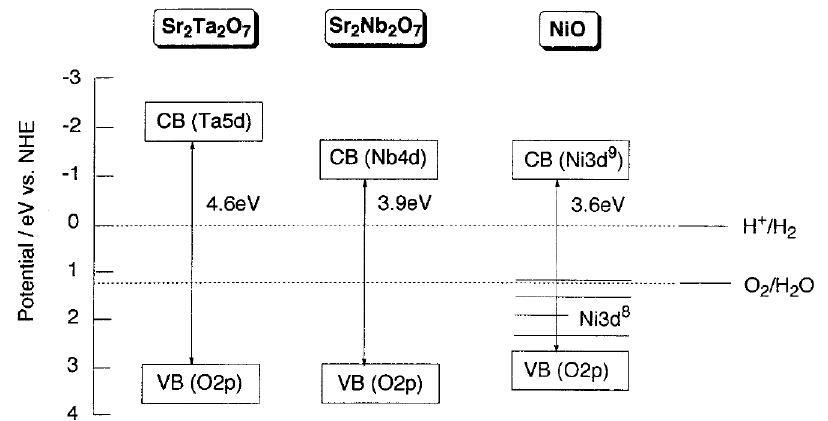
composite photocatalyst 2